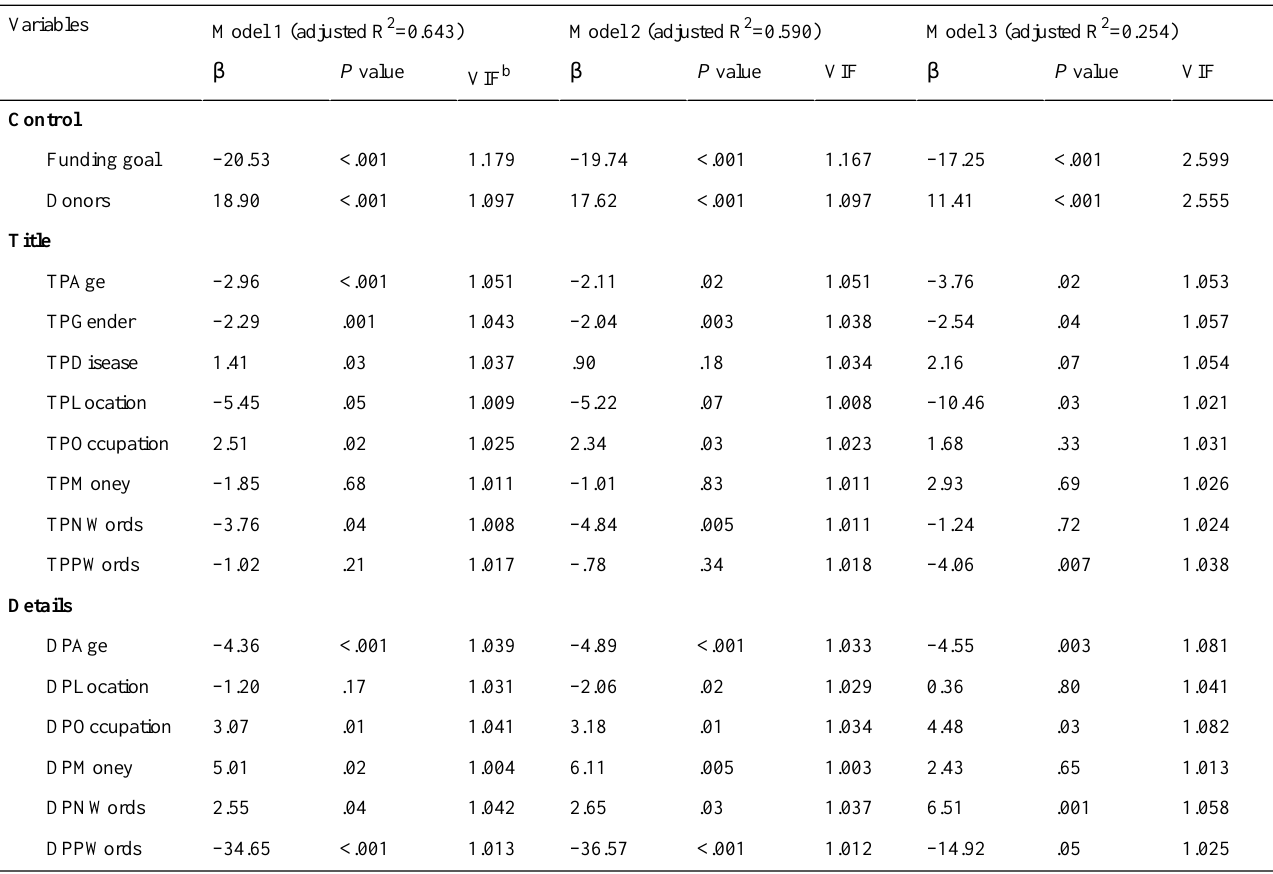
Table 6. Regression results of robustness tests.